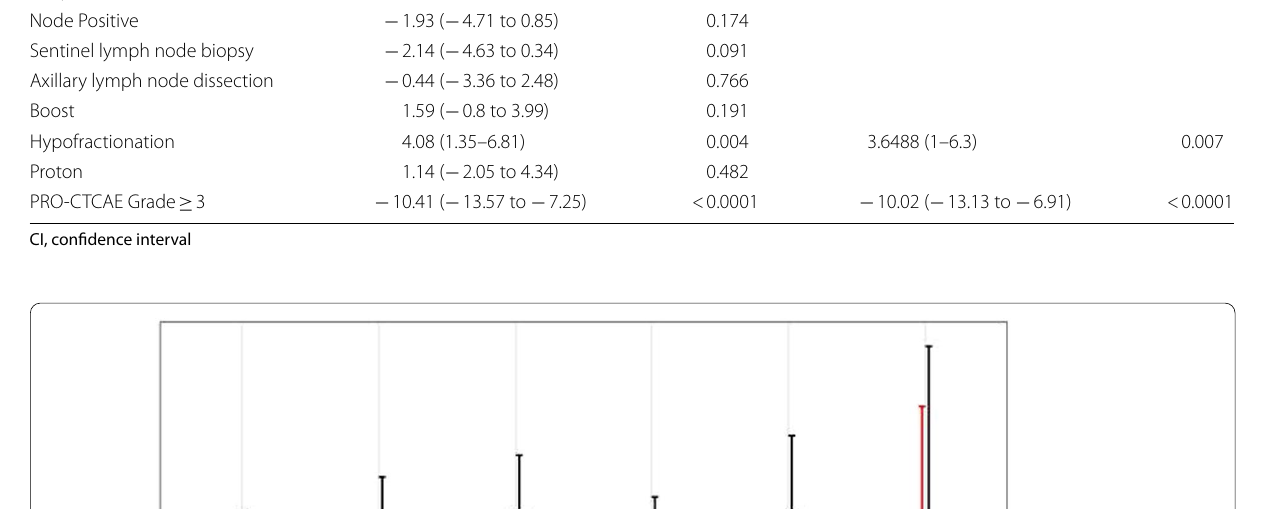
Table 4 Univariate and multivariate analysis showing estimates of LASA point changes